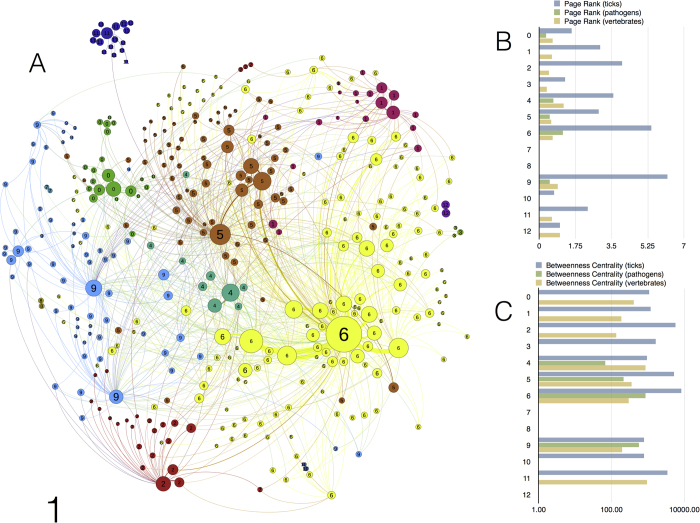
The network of ticks, vertebrates and pathogens without domesticated animals(a) The 13 clusters found by the modularity algorithm, represented according to the ForceAtlas2 scheme, randomly coloured, and numbered from 0 to 12 (the agglomerative algorithm include minimum values of 0). Each circle is a partner of the network, a vertebrate, tick, or pathogen (complete taxonomic information is provided in Supplementary Figure 1). The size of each circle is proportional to its NBC. Each line is a link between two nodes, and its colour is the same as that of the cluster. The width of each line is proportional to the weighted degree, a measure of the strength of the link between two nodes. (b) Values of the PR index for the ticks, pathogens, and vertebrates of the 13 clusters. (c) Values of the NBC for the ticks, pathogens, and vertebrates of the 13 clusters.